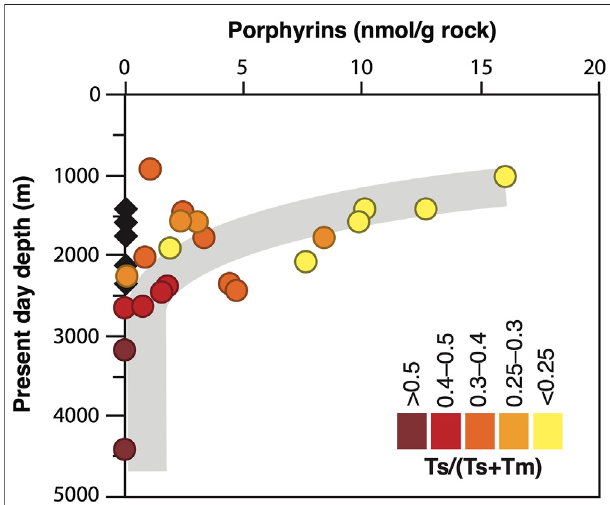
FIGURE 4 | Porphyrin preservation. Relationship between present-day burial depth of studied samples, their thermal maturity ( via the hopanoids Ts and Tm) and porphyrin content. Overall, the porphyrin content decreases with increasing burial and thermal maturity, which corresponds to the stratigraphic trend shown in Figure 5A . Despite some variation, the oldest stratigraphic units have mostly also experienced the greatest burial (see Table 1 ). Black diamonds indicate samples from the Athel silicilyte, which contain no porphyrins despite a low thermal maturity (0.18 – 0.28 on the Ts/(Ts + Tm)